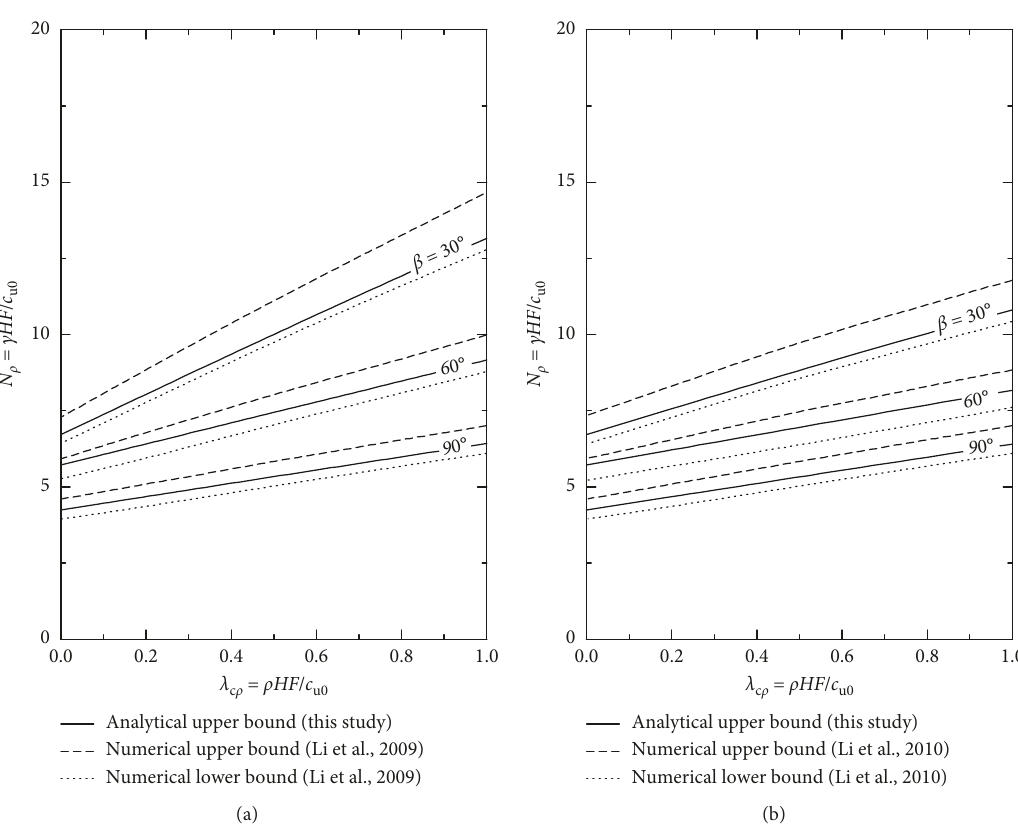
Figure 6: Comparisons between analytical upper bound results obtained from this study and the numerical upper and lower bound solutions presented by Li et al. (2009, 2010) for (a) cut slopes and (b) natural slopes with B / H �